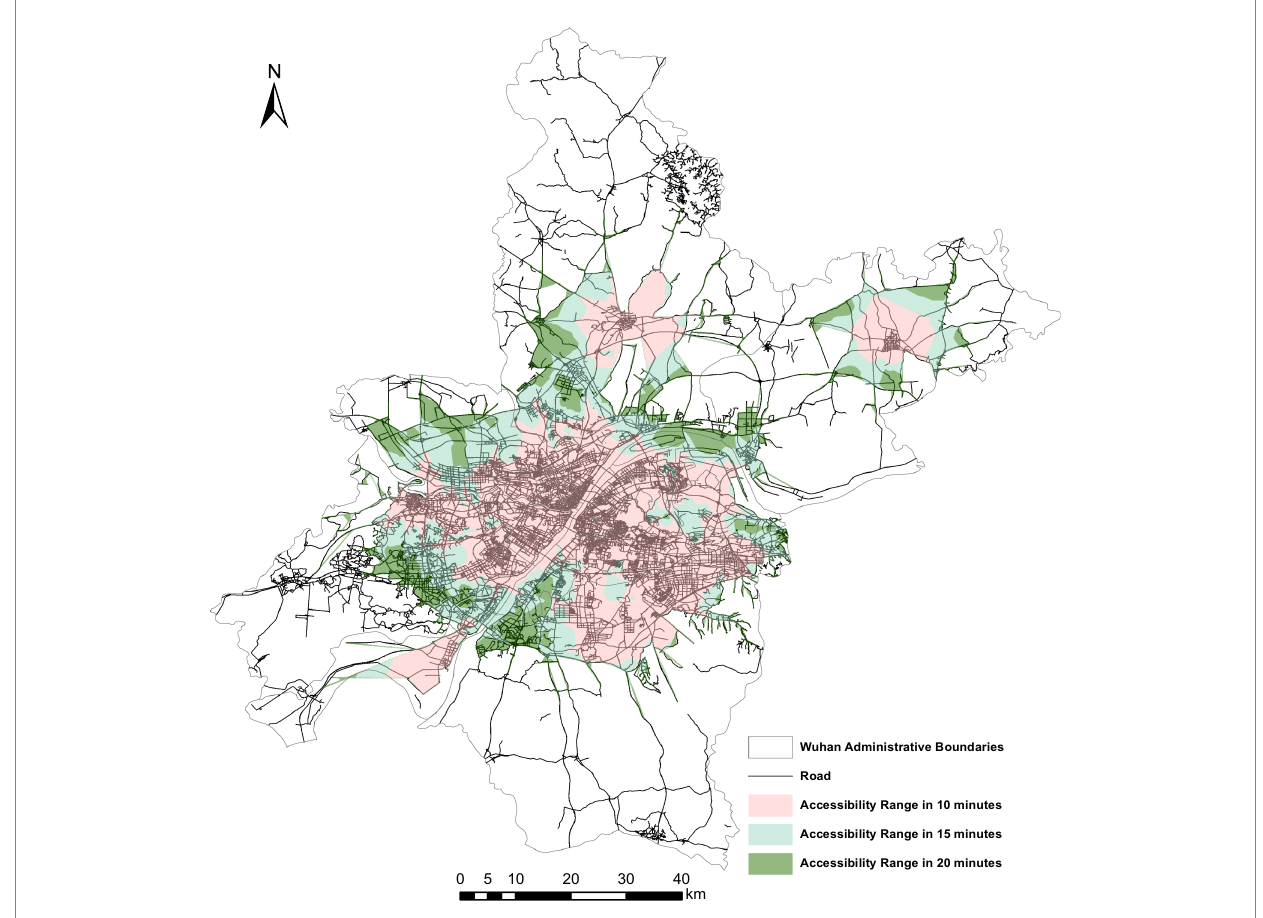
FIGURE 5 Accessibility of epidemic prevention facilities in